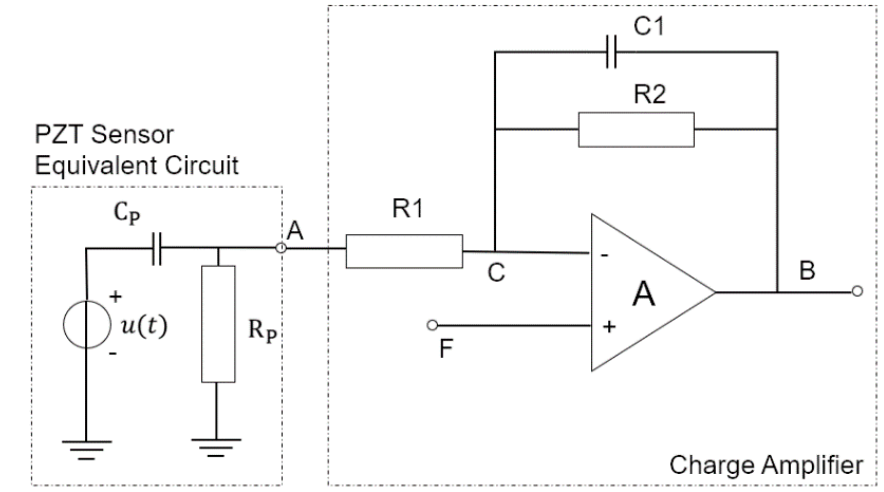
Figure 4. The scheme for the charge amplifier.